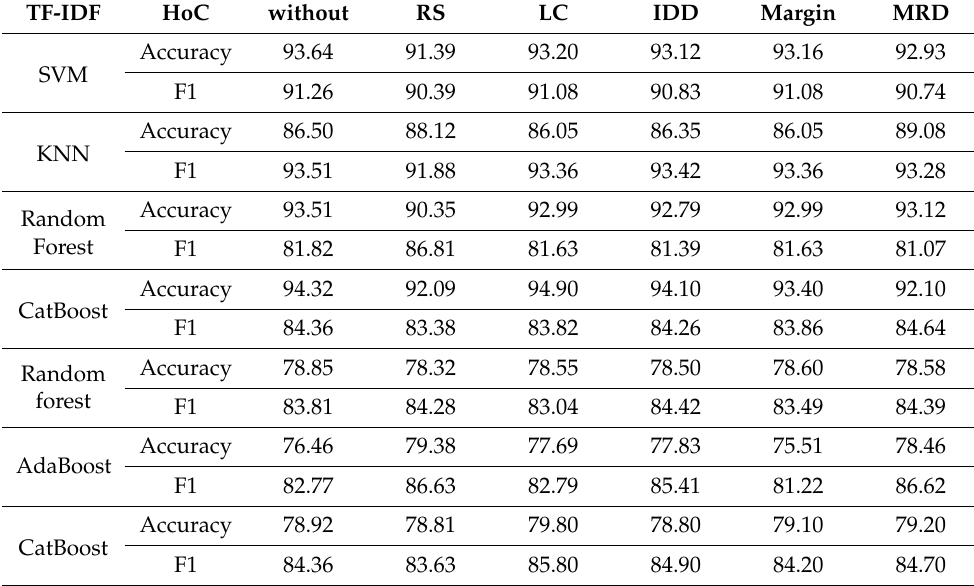
Table 4. Comparison of results with and without AL methods (TF-IDF) for HoC dataset.